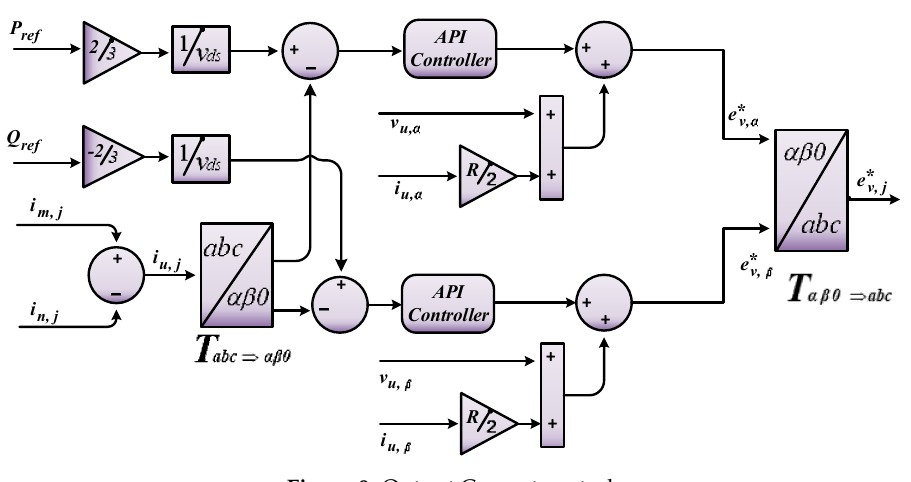
Figure 9. Output Current control.